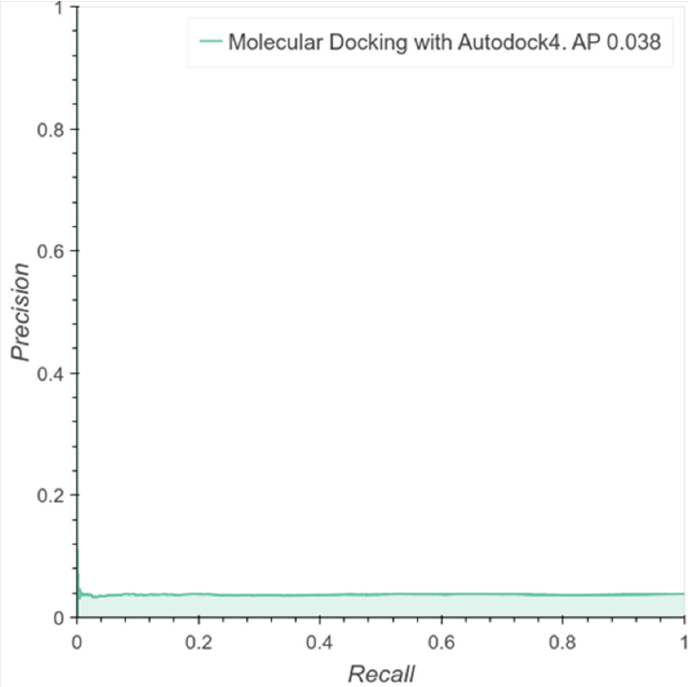
Fig 2. Performance of molecular docking as a classifier. Precision Recall Curve over the predictions computed with the binding energy of the molecular docking in the selected molecules against one of the 102 targets.